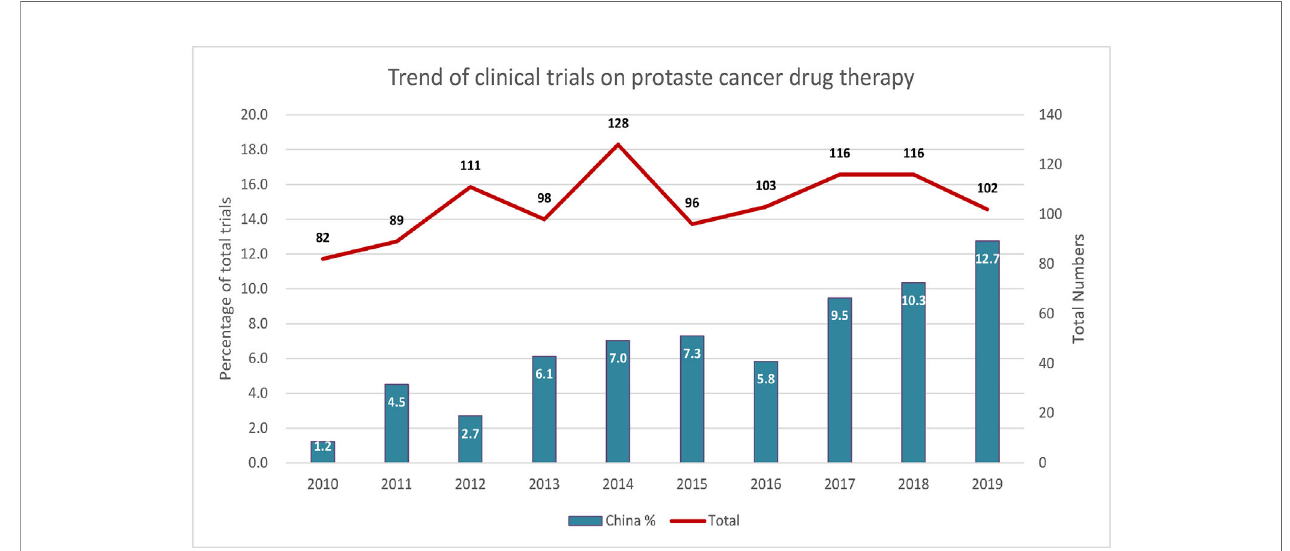
FIGURE 1 | Trends of clinical trials of prostate cancer therapy in China and worldwide. Left y -axis indicates the ratio of total trials, and right y -axis indicates the total number of